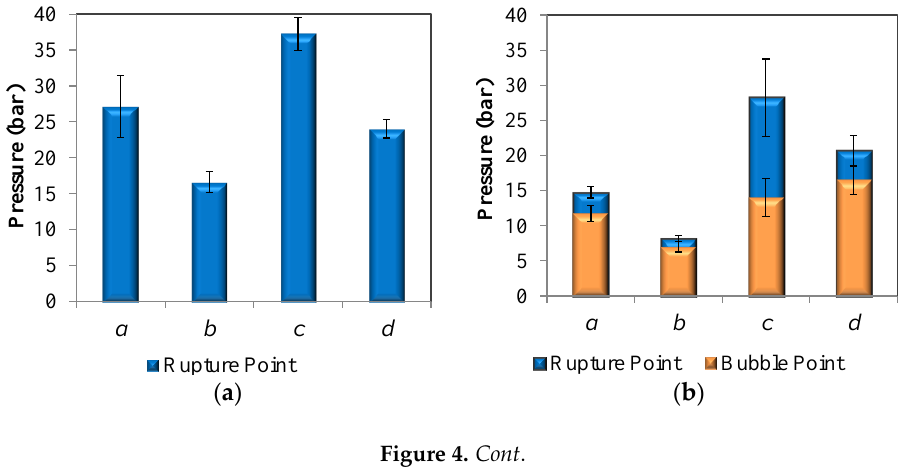
Figure 4. Cont . Figure 4. Cont .